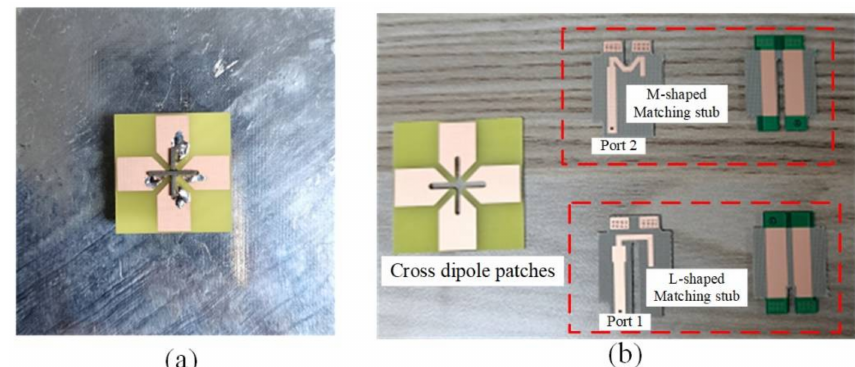
Figure 5. Fabricated antenna. ( a ) Top view. ( b ) Disassembled parts of the antenna.